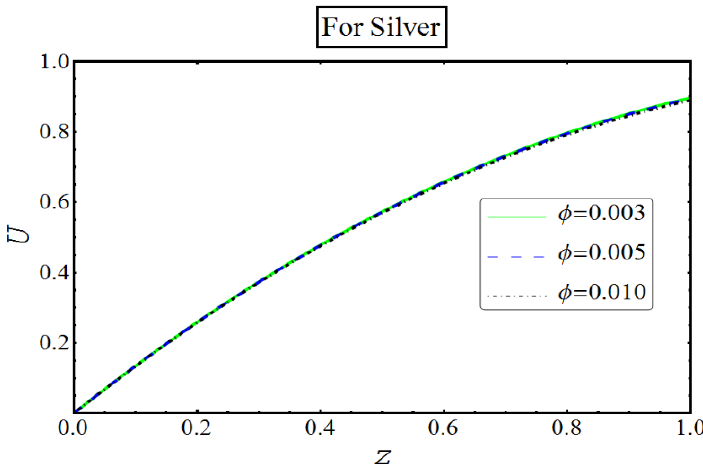
Figure 13. Effects of concentration particles on radial velocity with silver particles.